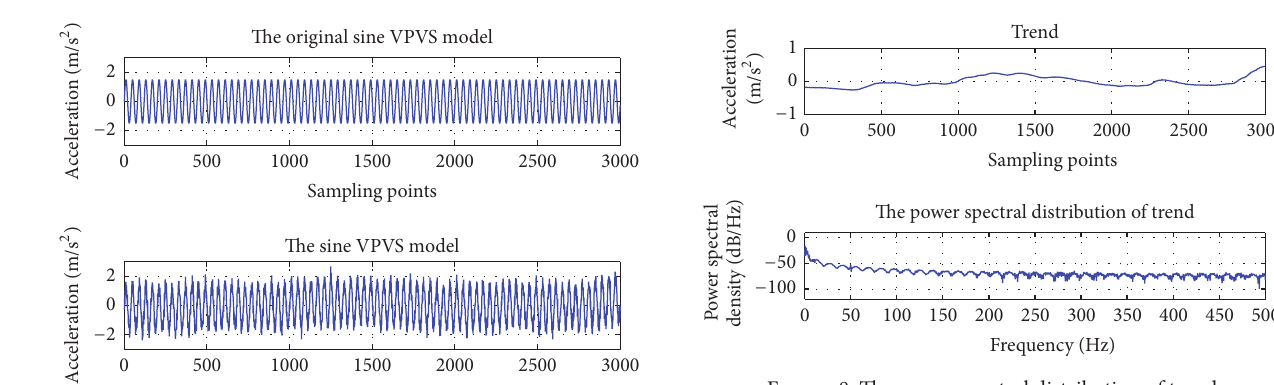
Figure 8: The power spectral distribution of trend.